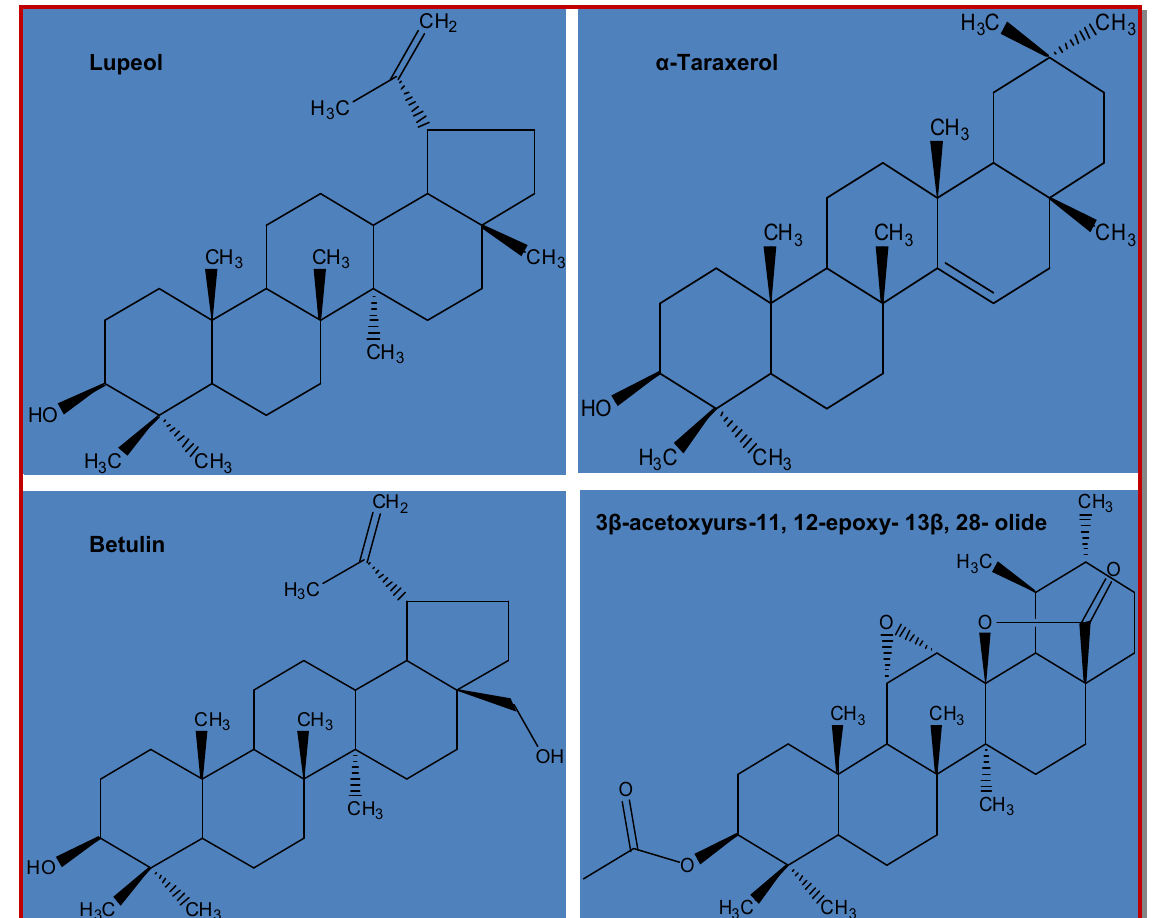
Figure 1: Chemical structure of isolated compounds from Rhododendron